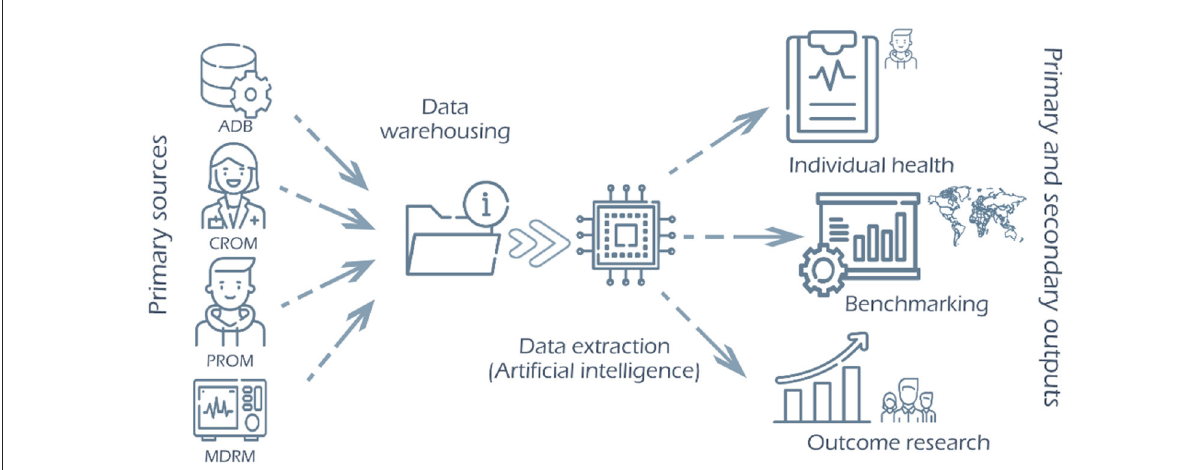
FIGURE2 New Health Information System structure implies the inclusion of data from primary sources (professional, patient, administrative databases and medical devices, including wearables) in centralized data warehousing and the development of means to extract the different information outputs from a unique data entry, answering to individual healthcare needs as much as the information requirements for administrative, public health and research purposes [QoL, Quality of Life; RWE, Real World Evidence; CROM, clinician-reported outcome measures (clinical indicators); PROM, patient-reported outcome measures (quality of life health outcome indicators); PREM, patient-reported outcome measures (patient experience indicators); MDRM, Medical Devices-Reported Measures (clinical indicator measured by medical devices);